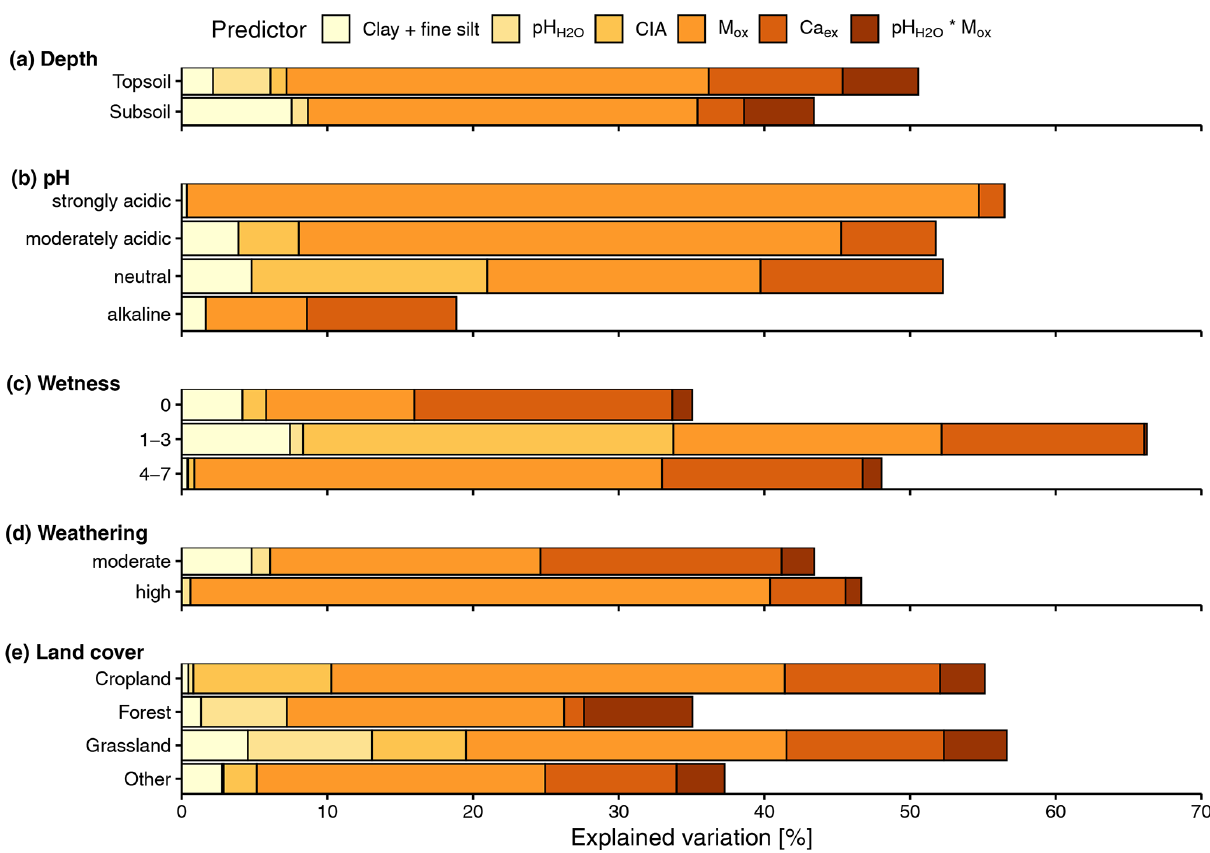
Figure 4. Explained variation (based on marginal R 2 ) for each fixed effect, based on sequential fitting of the linear mixed-effects models grouped by (a) depth (0–20cm – topsoil; 20–50cm – subsoil), (b) pH classes (3.9–5.2pH – strongly acidic; 5.2–6.1 – moderately acidic;